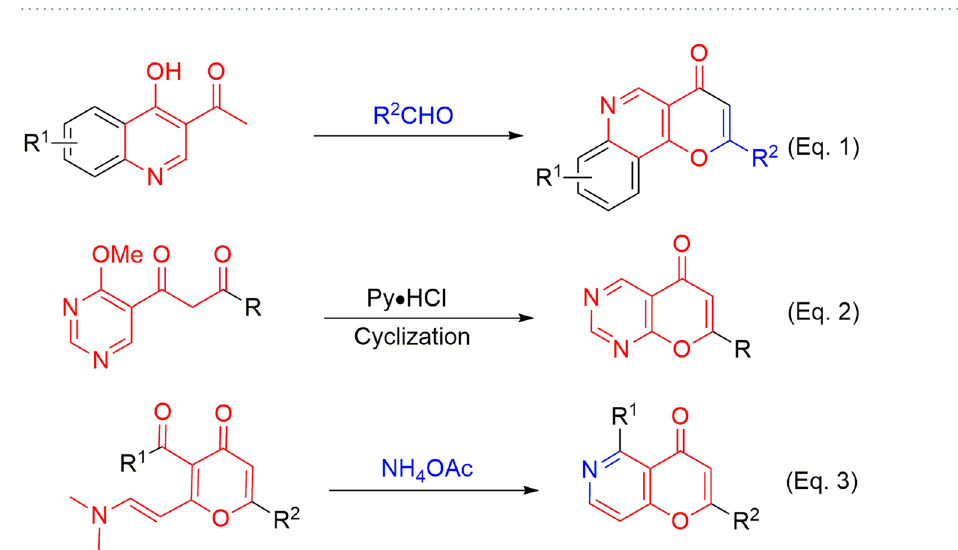
Figure 2. Reported methods for preparation of 6-aza-chromone.